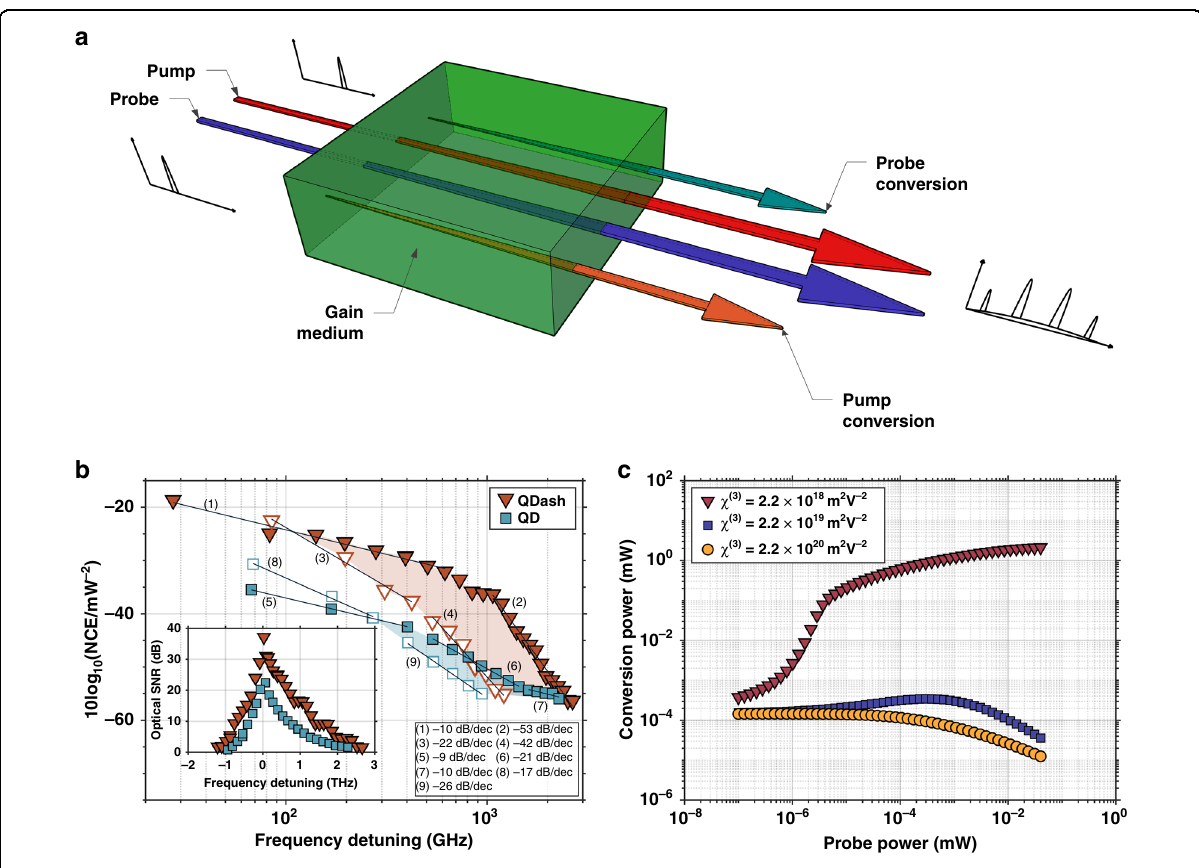
Fig. 4 Optical nonlinearities. ( a ) Schematic representation of the four-wave mixing process in a semiconductor gain medium; ( b ) The normalized conversion ef fi ciency NCE (solid/empty scatter – positive/negative detuning, respectively) and optical SNR (inset); ( c ) conversion power in terms of probe power for different χ (3) values: 2.2 × 10 − 20 , 2.2 × 10 − 19 and 2.2 × 10 − 18 m 2 /V